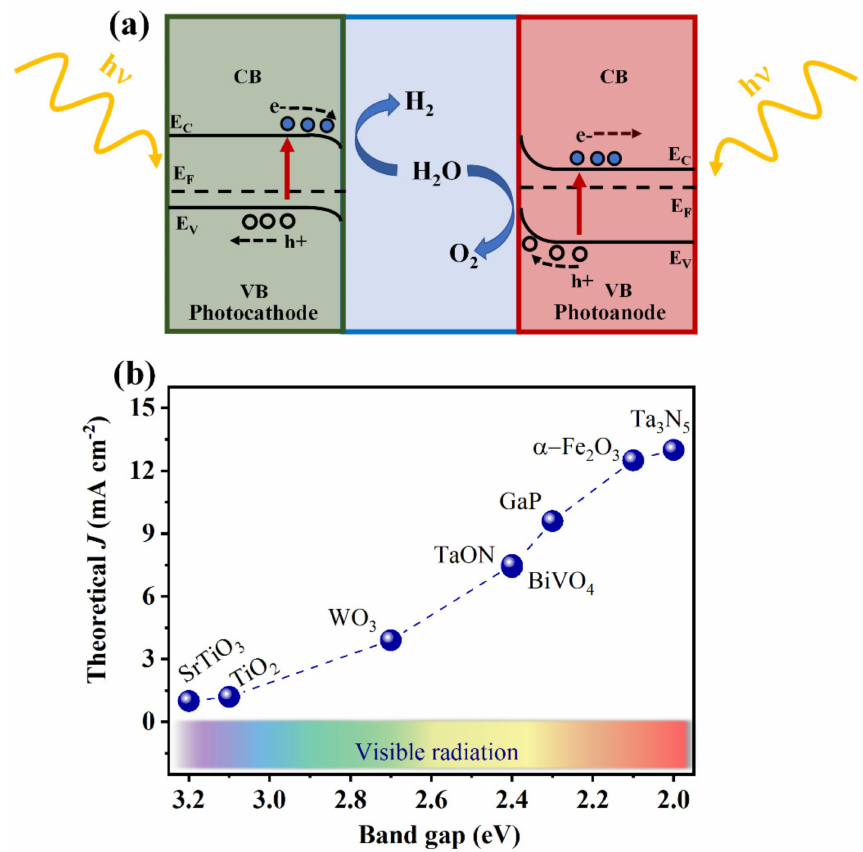
Figure 1. ( a ) Schematic of the main design aspects for a PEC design. Ec and Ev represent the conduction band (CB), valence band (VB) edges, and E F represents the Fermi level. ( b ) Theoretical photocurrent density (J) values towards sunlight-driven water splitting for n-type semiconductors, materials, and their bandgap